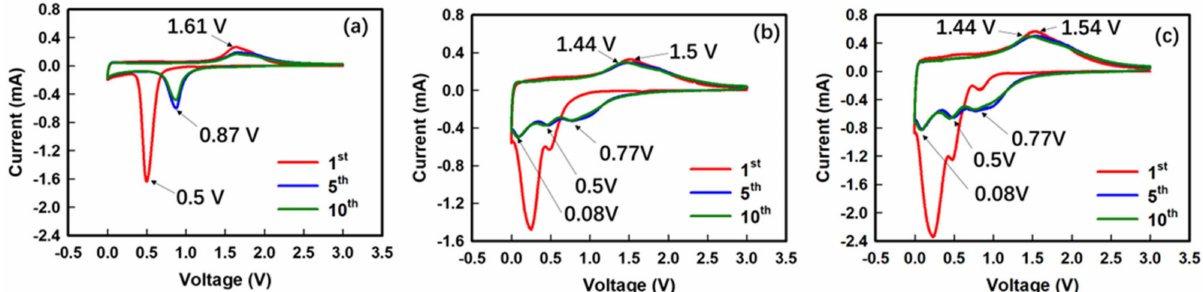
Figure 6. Cyclic voltammetry (CV) curves for the proposed HEMO anodes. CV curves for ( a ) HEMO1, ( b ) HEMO2, and ( c ) HEMO3 anodes for LIBs between 0.05 and 3.0 V, at a scan rate of 0.1 mV s − 1